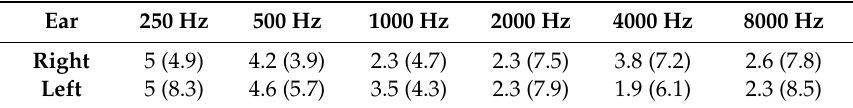
Table 1. Average audiometric thresholds (in dB Hearing Level (HL)) and standard deviations (within parentheses) at di ff erent octave frequencies in the two ears for participants in the